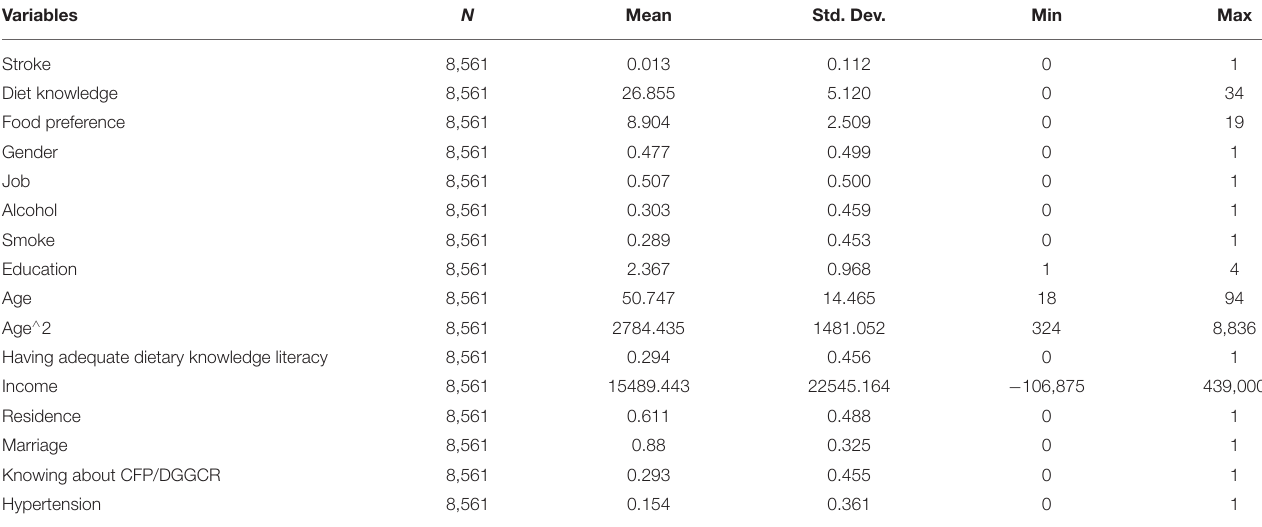
TABLE 1 | Summary